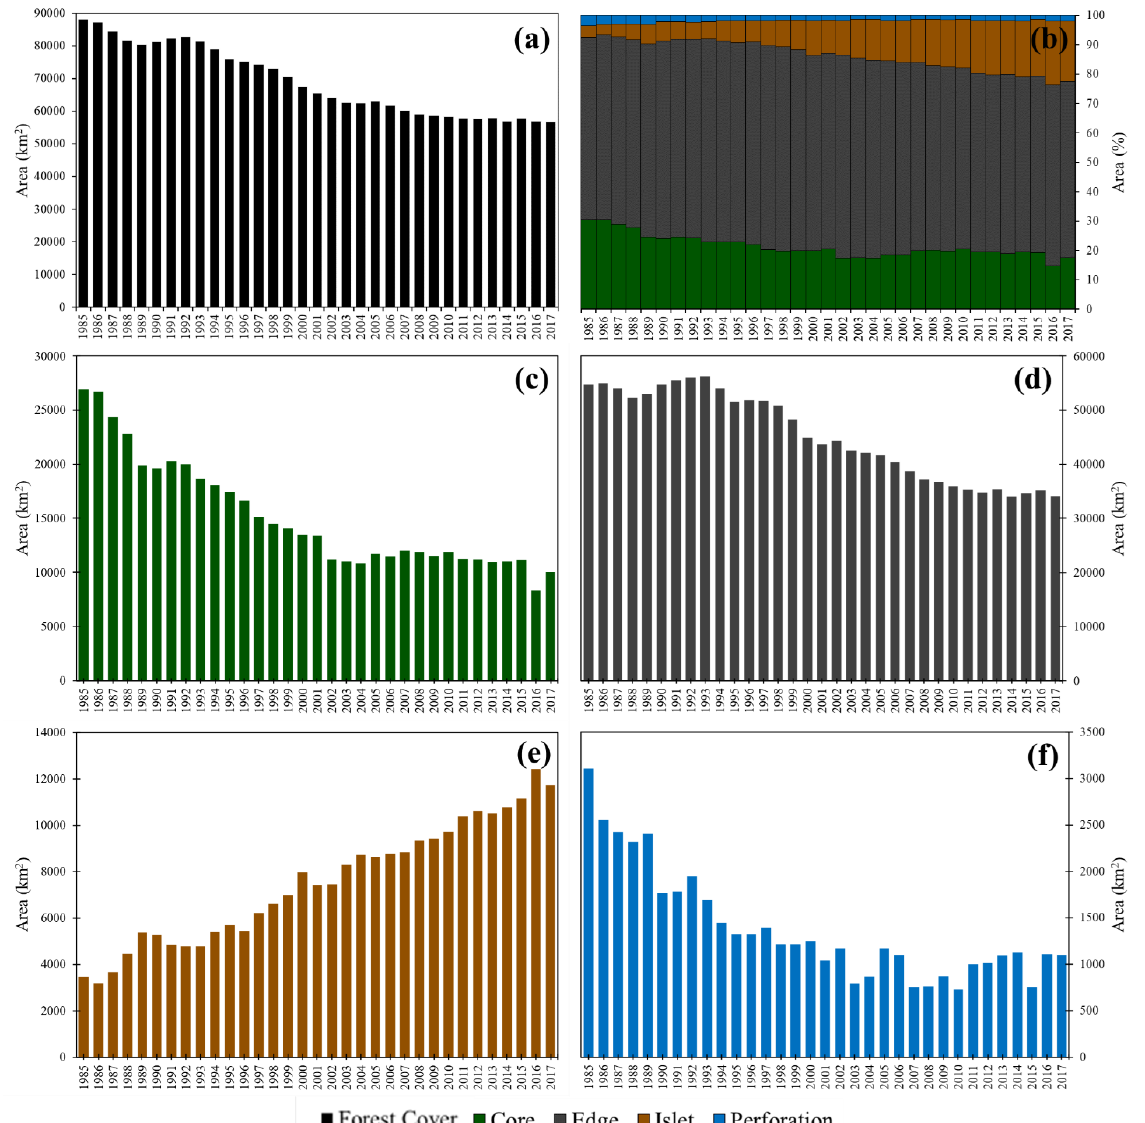
Figure 2. ( a ) Annual forest cover between 1985 and 2017 in the Maranhão Amazon, Brazil. ( b ) Frag- mentation class during the study period as a percentage of the total forest cover in each year. ( c – f ) Annual area of each fragmentation class between 1985 and 2017. Note that the figures have the y -axis at different scales.